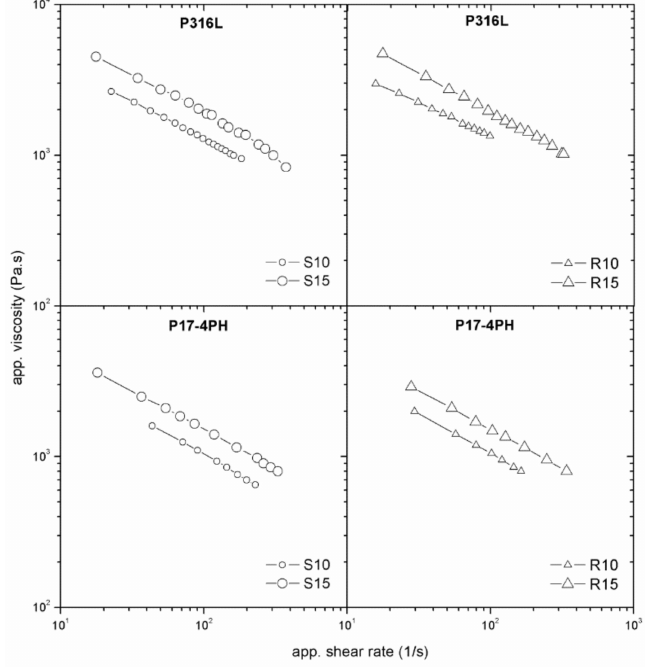
Figure 4. Effect of die dimensions on flow properties of stainless-steel powders 316L (P316L) and 17-4PH (P17-4PH) in the partly water-soluble binder system PolyMIM (P).